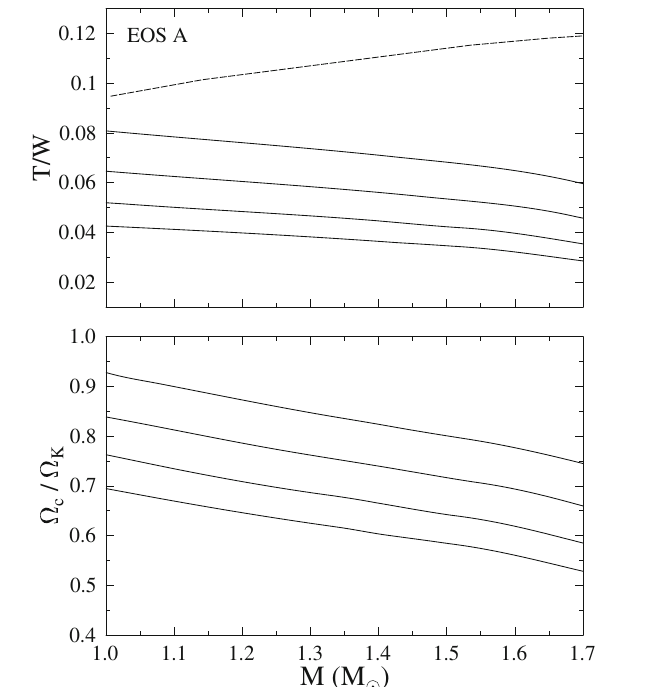
Fig. 14 The l = m neutral f -mode sequences for EOS A. Shown are the ratio of rotational to gravitational energy T / W (upper panel) and the ratio of the critical angular velocity Ω c to the angular velocity at the mass-shedding limit for uniform rotation (lower panel) as a function of gravitational mass. The solid curves are the neutral mode sequences for l = m = 2 , 3 , 4, and 5 (from top to bottom), while the dashed curve in the upper panel corresponds to the mass-shedding limit for uniform rotation. The l = m = 2 f -mode becomes CFS-unstable even at 85% of the mass-shedding limit, for 1 . 4 M (cid:3) models constructed with